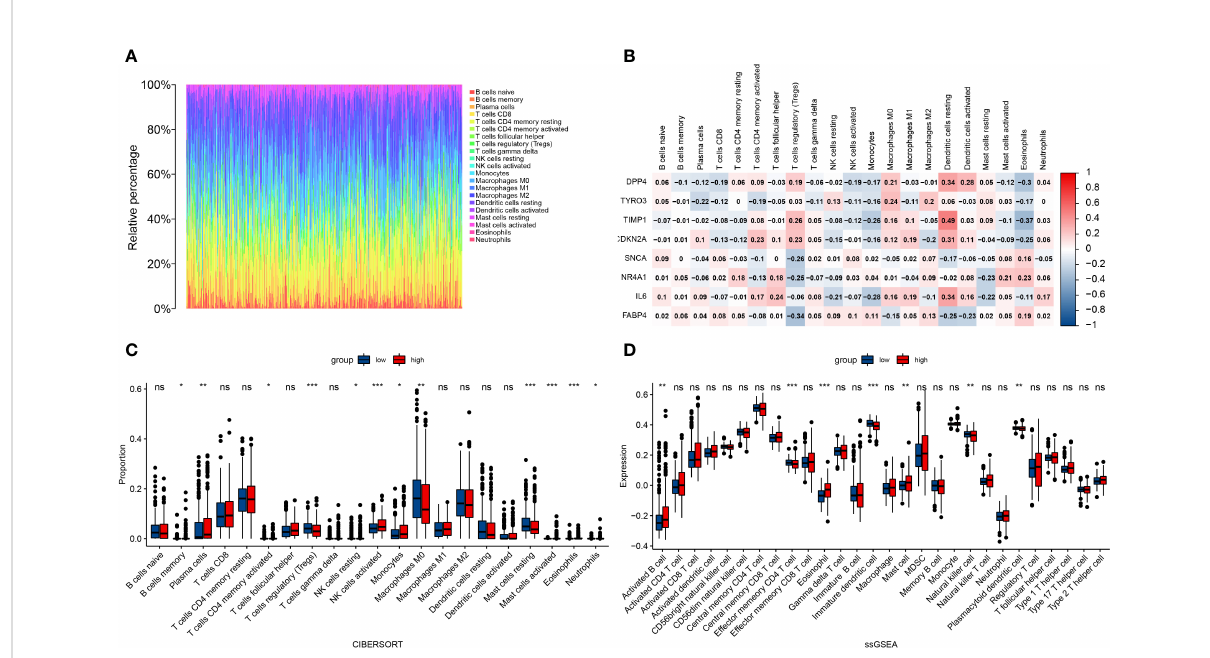
FIGURE 8 Correlation between the risk score of the prognostic risk model and immune cells. (A) Immune cell proportions for each tumor patient. (B) The correlation between eight FRGs and immune cells. (C) The in fi ltration levels of 22 immune cell subtypes in the high and low risk groups. (D) Quanti fi cation of distinct immune cell subsets by ssGSEA.*: p < 0.05, ;** : p < 0.01, ***: p < 0.001. ns: no signi fi